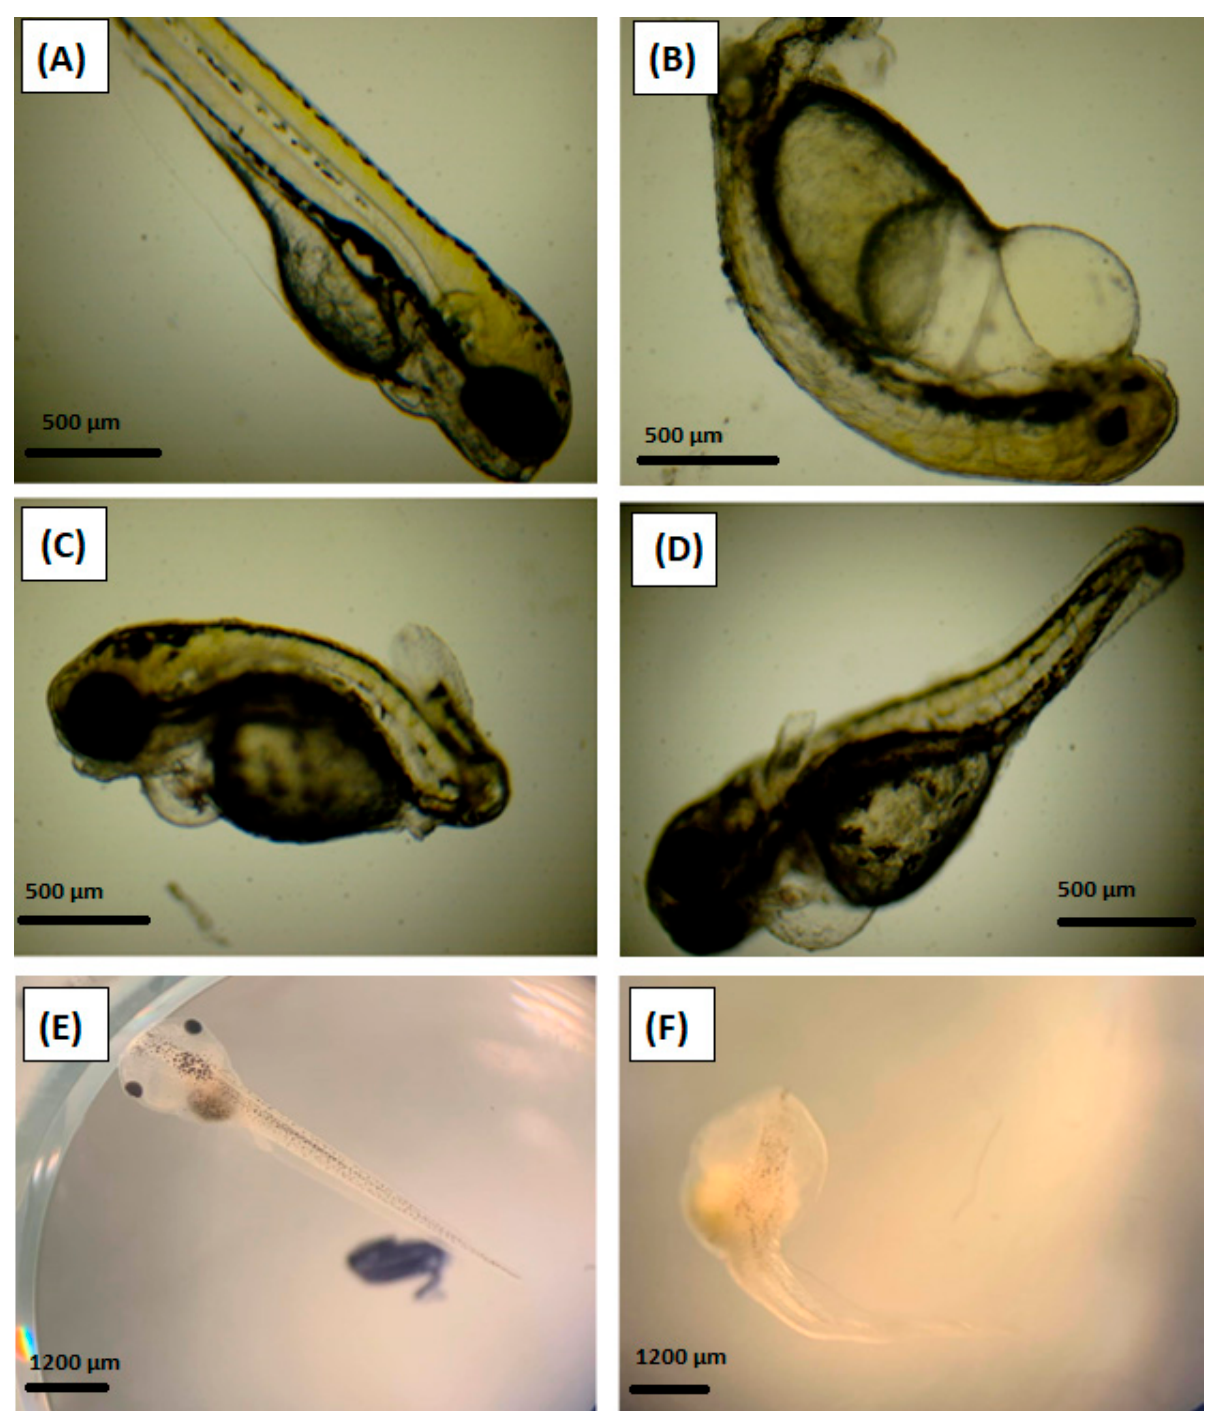
Figure 4. ( A ) Hatched zebrafish embryo in the control group at 96 h post-fertilization; ( B ) malformation of zebrafish embryo (oedema of heart and yolk sac, total body deformation) in the experimental group exposed to 10,000 µ g/L of fluoxetine hydrochloride at 72 h post-fertilization; ( C ) malformation of zebrafish embryo (body deformation, pericardial oedema) in the experimental group exposed to 10,000 µ g/L of fluoxetine hydrochloride at 96 h post-fertilization; ( D ) malformation of zebrafish embryo (body deformation, pericardial oedema) in the experimental group exposed to 100,000 µ g/L of citalopram hydrochloride at 96 h post-fertilization; ( E ) African clawed frog embryo in the control group at 72 h post-fertilization; ( F ) malformation of African clawed frog embryo (total body deformation) in the experimental group exposed to 1000 µ g/L of fluoxetine hydrochloride at 72 h